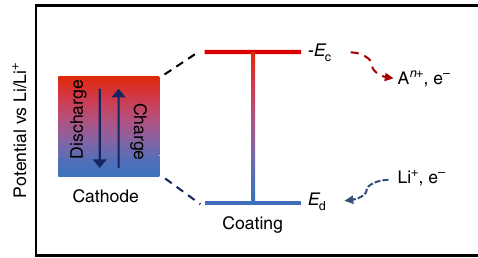
Figure 3 | Electrochemical stability window of the coating. The schematic compares the operating voltage window of a cathode to charge and discharge potentials (that is, E c and E d , respectively) of an electrochemically stable coating.